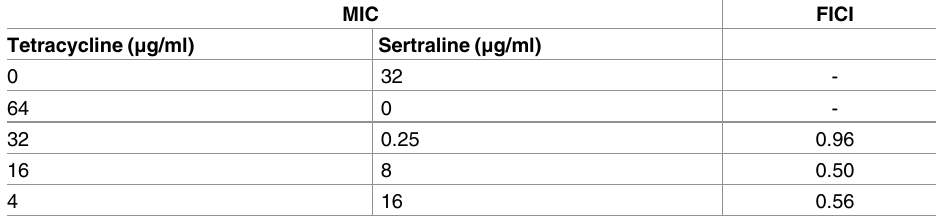
Table 2. Minimal inhibitory concentration (MIC) of sertraline and tetracycline alone or combined. For each combination exposureon sertralineand tetracycline, the fractional inhibitoryconcentration index (FICI) is